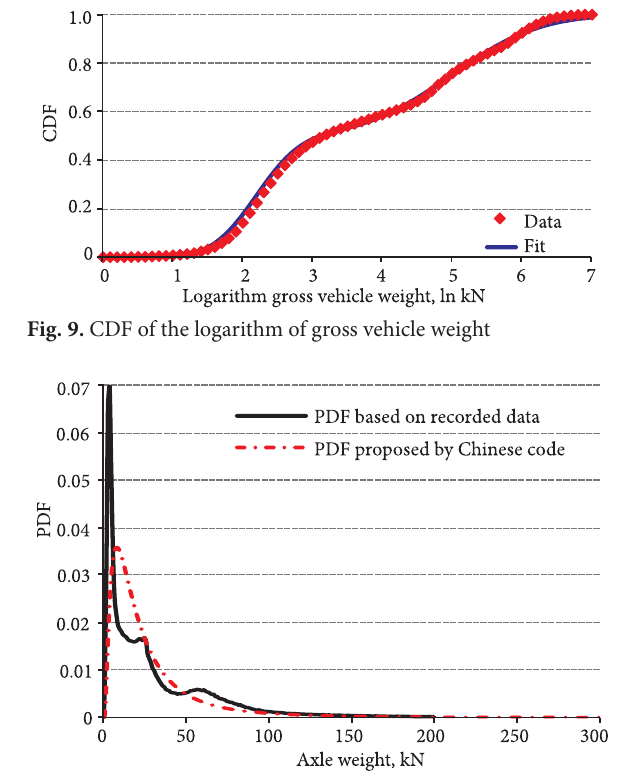
Fig. 8. PDF of the logarithm of gross vehicle weight